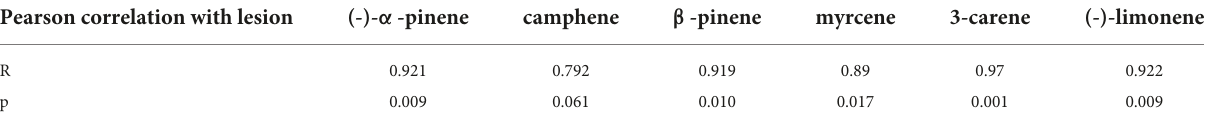
TABLE 3 Correlation analysis for the pathogenicity and monoterpenoid changes at 30